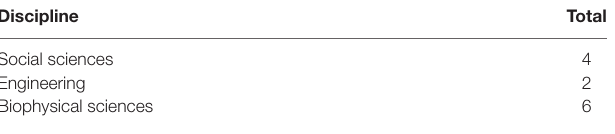
TaBle 3 | Disciplinary divides (capacity building).